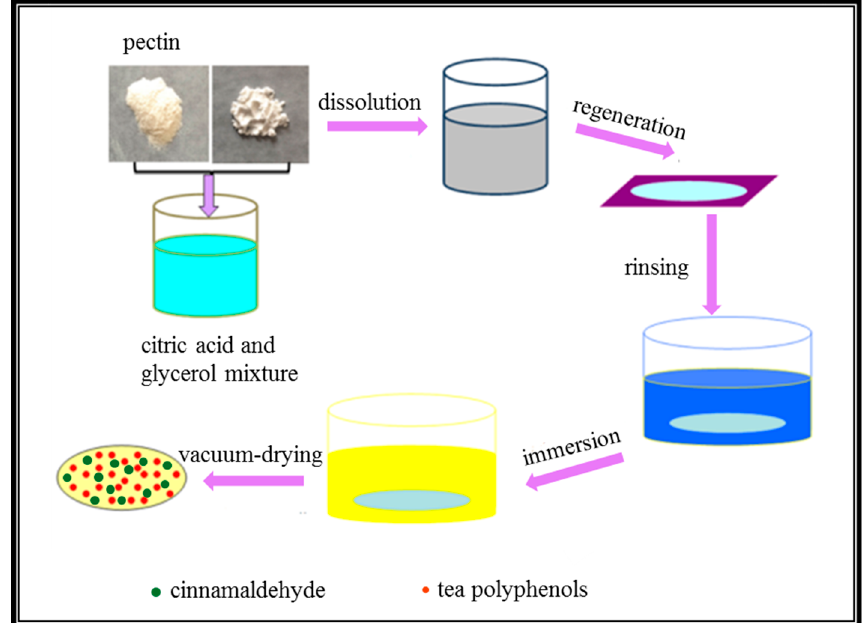
Figure 1. Schematic illustration of the preparation of pectin/cellulose (PC) composite films. Table 1. Cinnamaldehyde and tea polyphenols concentrations in the PC films. Cinnamaldehyde (%) TP Concentration (mg/mL)